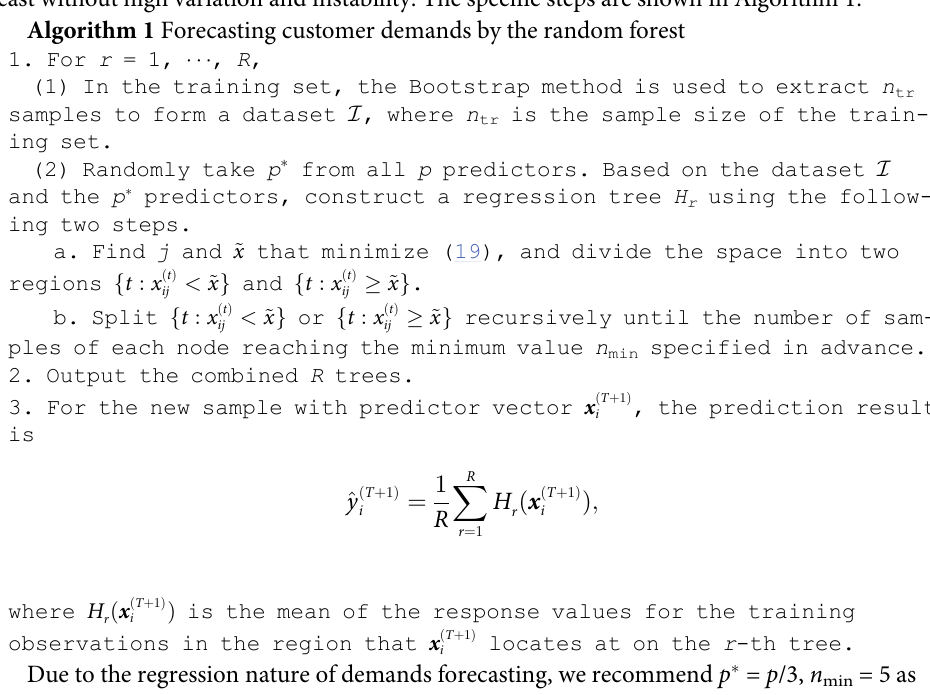
Algorithm 1 Forecasting customer demands by the random